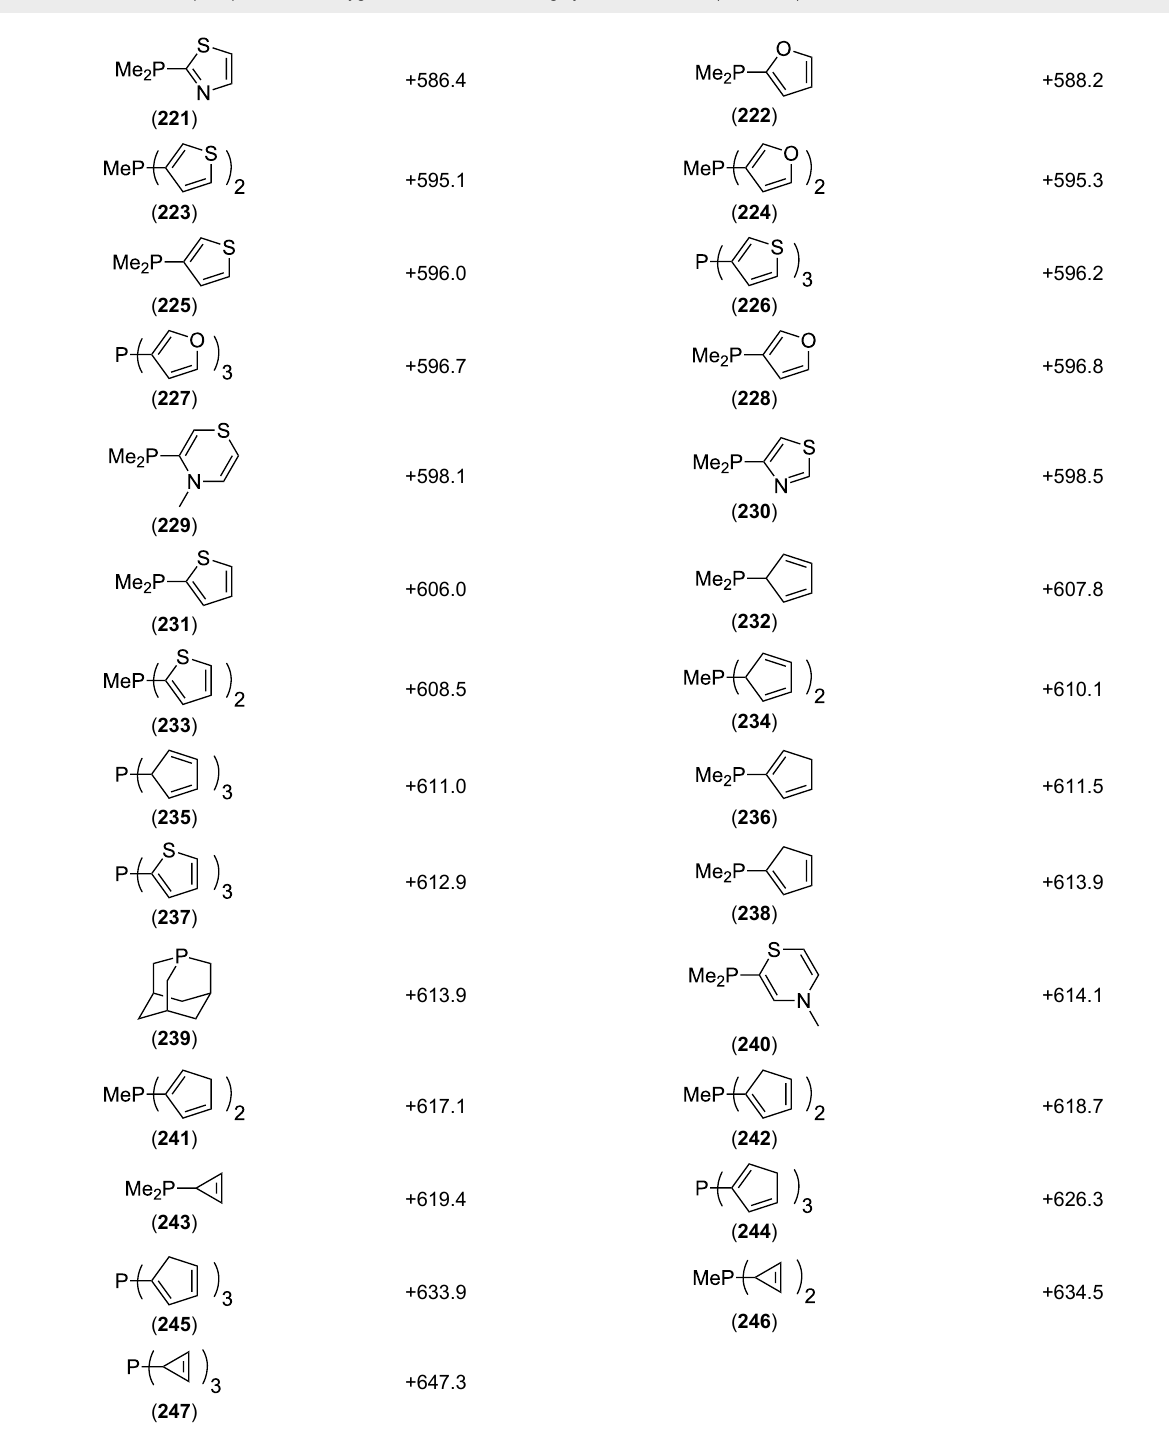
Table 5: MCA values of phosphanes with oxygen- and sulfur-containing cyclic substituents.